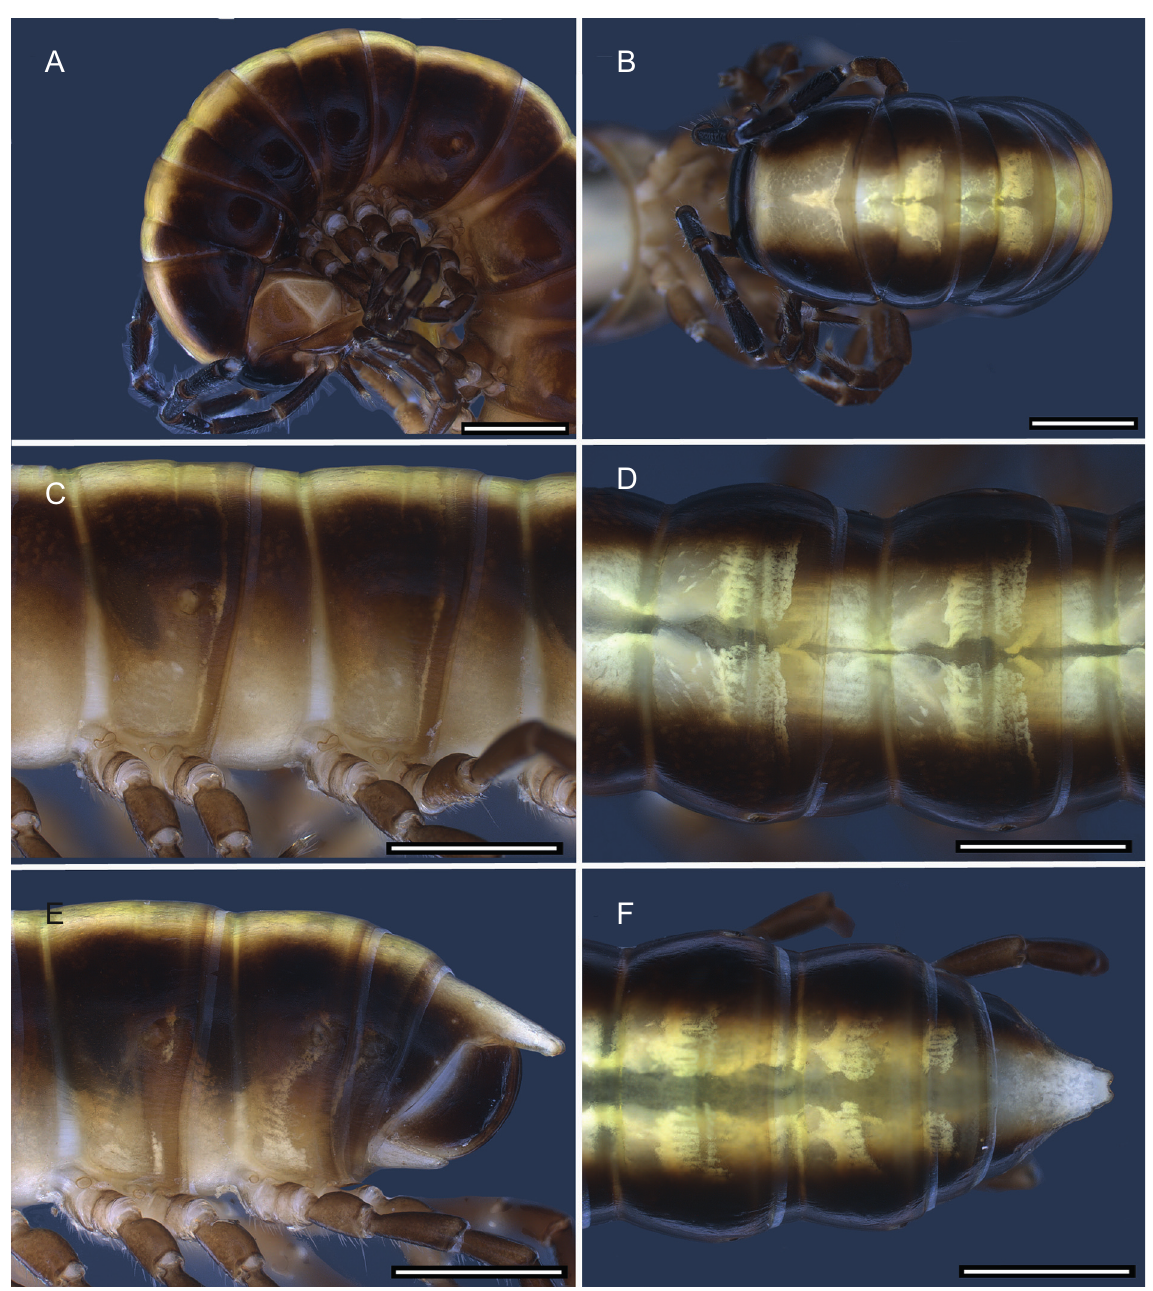
Fig. 15. Pogonosternum laetificum Jeekel, 1982, ♂, from Marysville, Mt Margaret Road (NMV K-12109). A – B . Anterior rings A . Left lateral view. B . Dorsal view. C – D . Rings 10 and 11. C . Left lateral view. D . Dorsal view. E – F . Posterior rings. E . Left lateral view. F . Dorsal view. Scale bars: 1